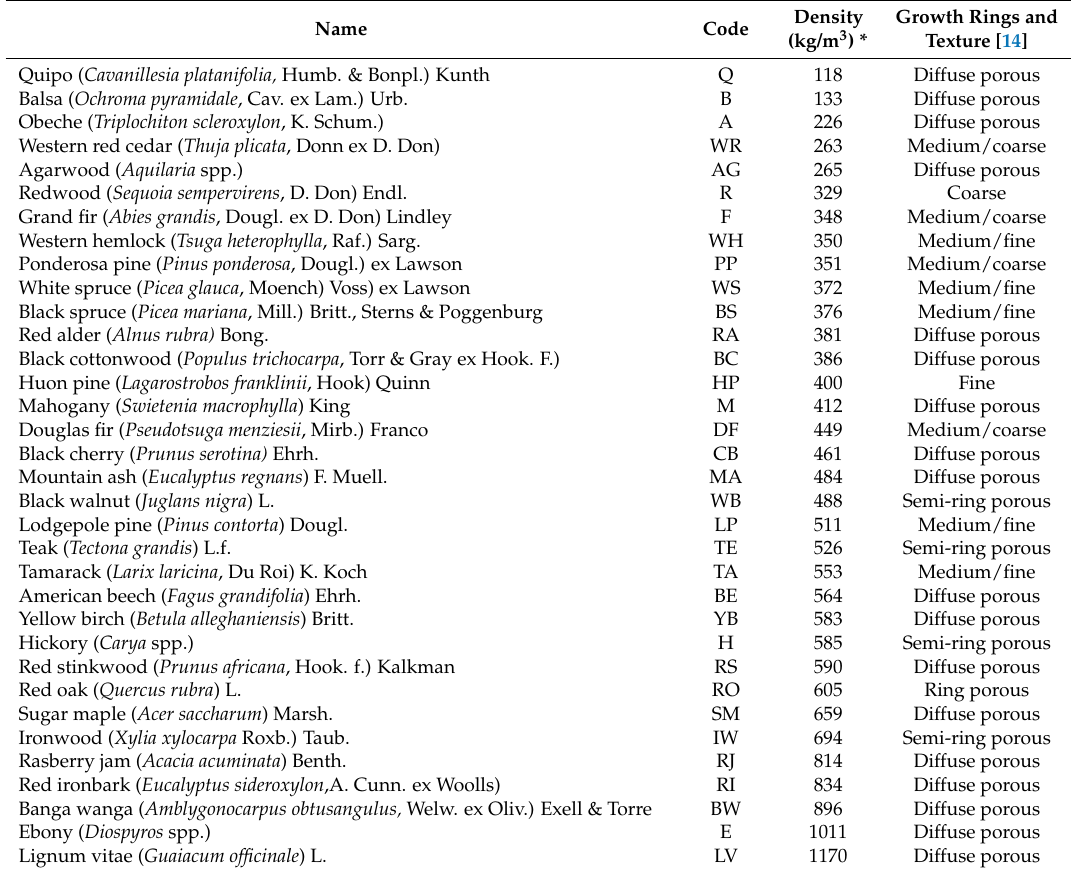
Table 1. Wood species used for an experiment that examined the relationship between wood density and grain